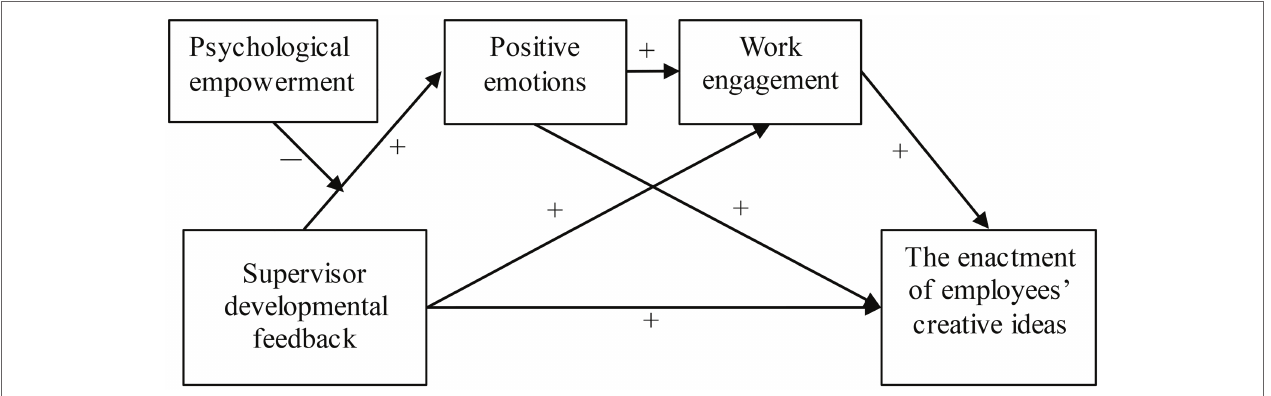
FIGURE 1 | The hypothesized